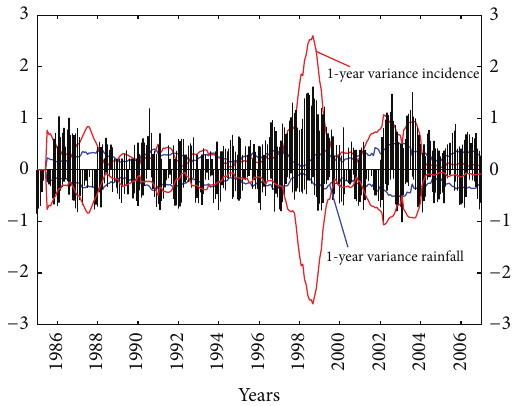
Figure 6: The 1-year variance time series for monthly relative (sqrt) incidence of American Tegumentary Leishmaniasis cases (red line) and (sqrt) rainfall (blue line). The relative (sqrt) incidence pattern is shown in upward axis (in black bars), while (sqrt) rainfall is shown in downward axis (in black bars) in Or´an, Salta, Argentina, period 1985–2007.